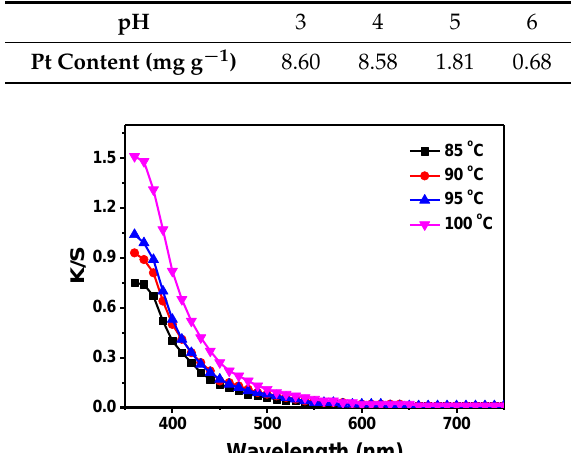
Figure 5. ( a ) K/S curves and ( b ) UV-vis diffuse reflectance absorption spectra of silk fabrics treated in the presence of 0.3 mM of H 2 PtCl 6 at different pH values. Table 2. Pt content of silk fabrics treated at different pH values with 0.3 mM of H 2 PtCl 6 at 90 °C.